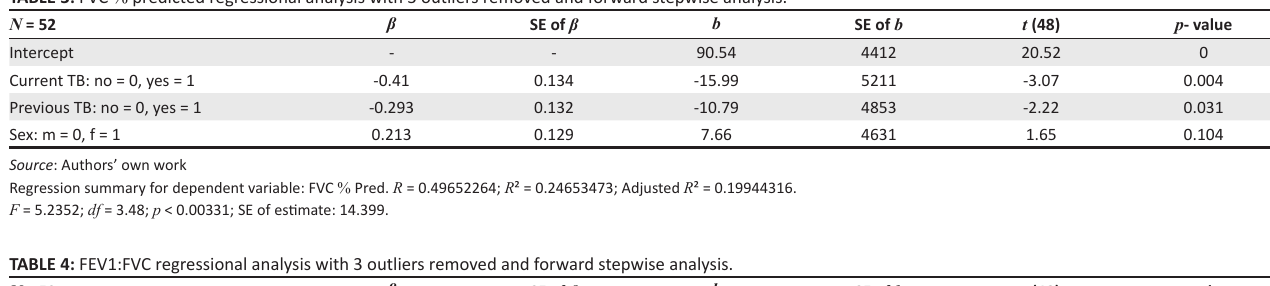
TABLE 4: FEV1:FVC regressional analysis with 3 outliers removed and forward stepwise analysis. N = 52 β SE of β Intercept